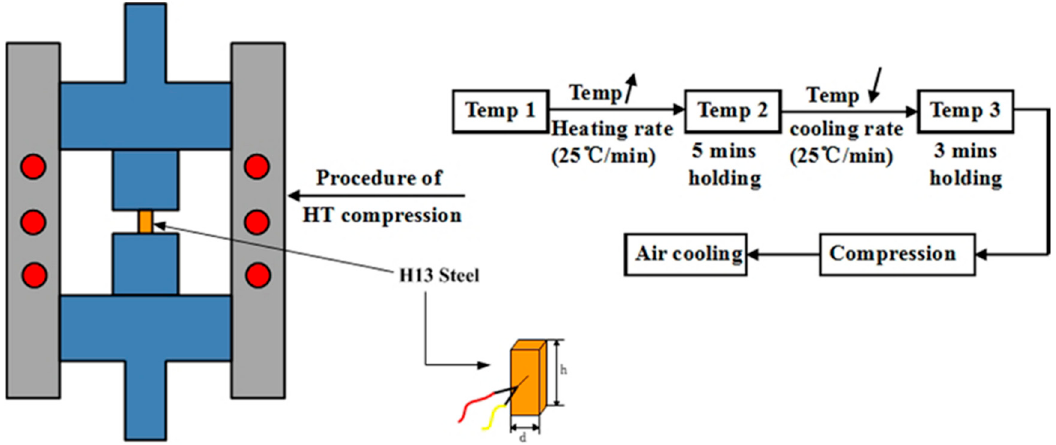
Figure 3. Compression tester and specimen for high temperature compression.